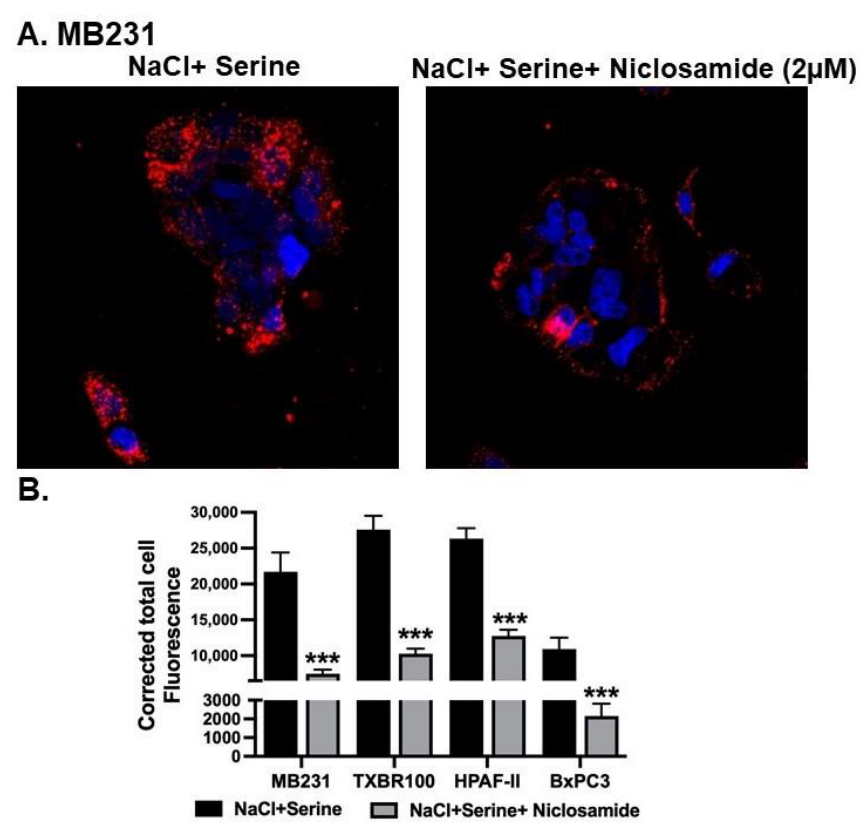
Figure 4. Effect of niclosamide on SLC38A5-mediated macropinocytosis. ( A ) Cellular uptake of TMR-dextran was used to monitor macropinocytosis activity in MB231 cells. The perifusion buffer contained NaCl and serine (1 mM). The assay was done in the absence or presence of niclosamide (2 µ M). ( B ) The experiment was repeated in three other cell lines (TXBR-100, HPAF-II and BxPC3), and fluorescence signals were quantified as CTCF (corrected total cell fluorescence). Data are shown as mean ± S.E.M. ***, p < 0.001.